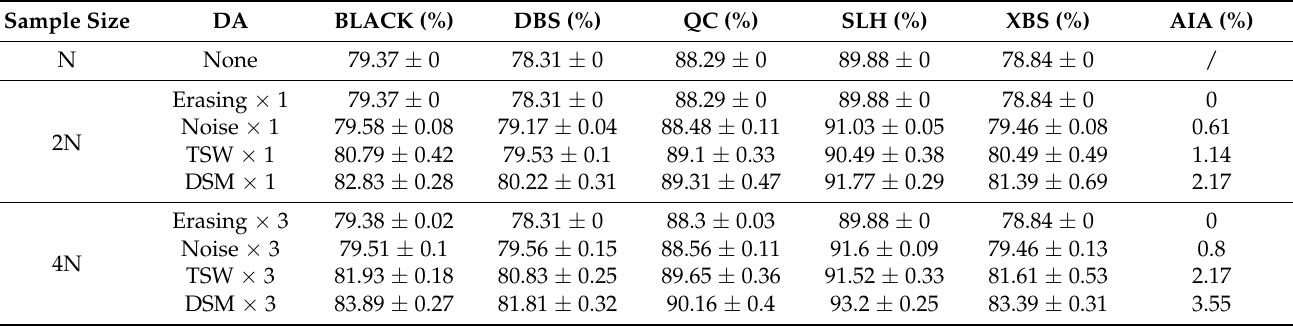
Table 2. Results of KNN training using G1 and G2 data.